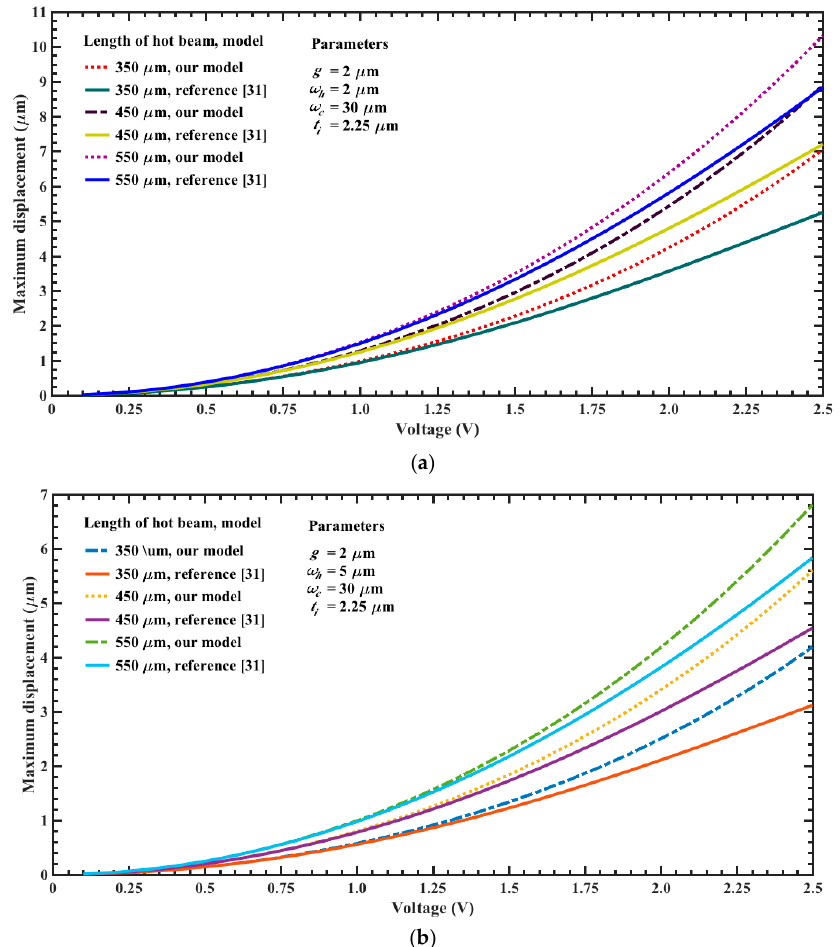
Figure 10. Maximum out-of-plane displacements of the electrothermal actuator tip as a function of bias voltage, regarding different lengths and two width values for the upper beams: ( a ) 2 μ m and ( b ) 5 μ m.